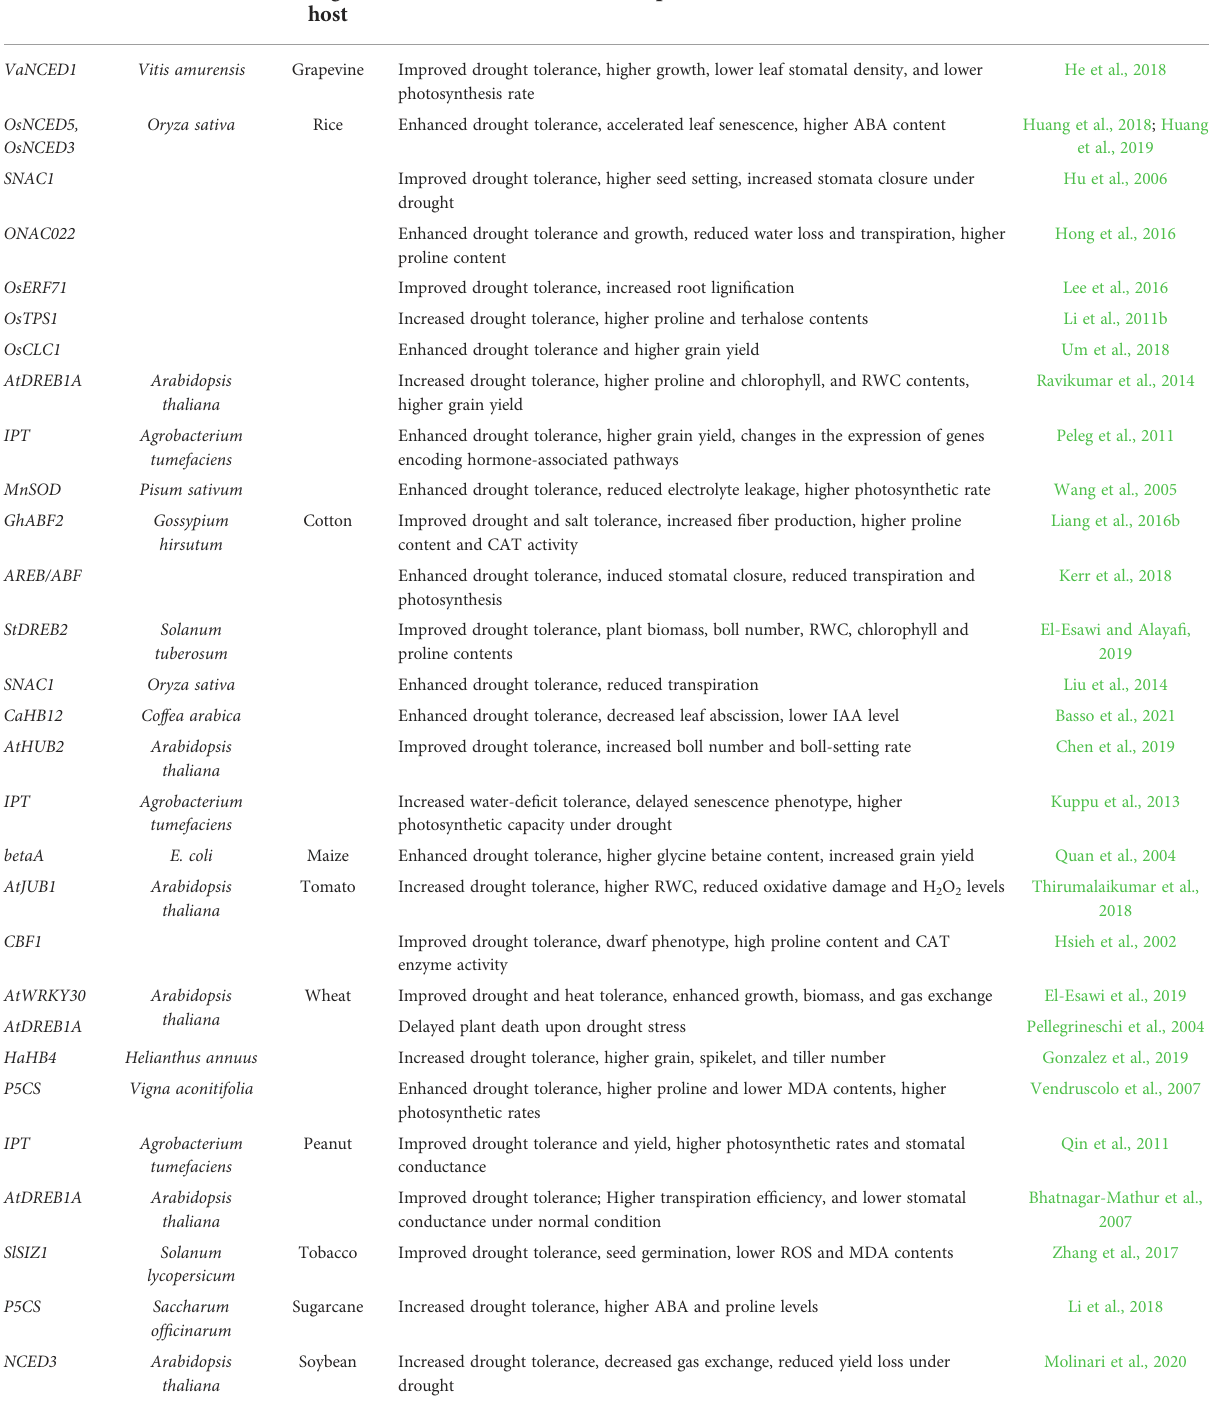
TABLE 2 Improving drought stress tolerance in transgenic